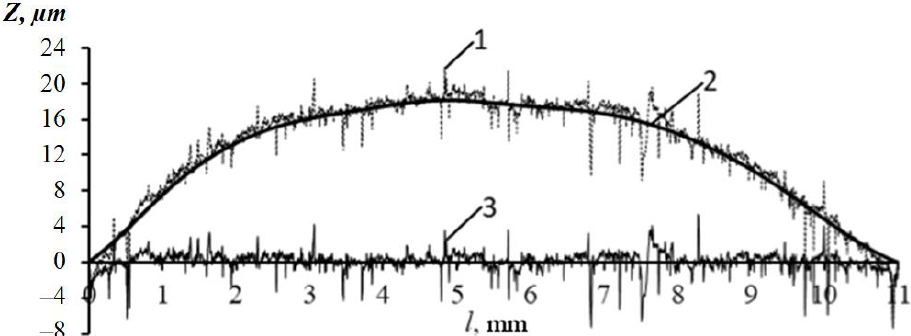
Figure 3. Representative view of separation of initial surface profile (1) into smoothed profile (2) for curvature determination and roughness profile (3).